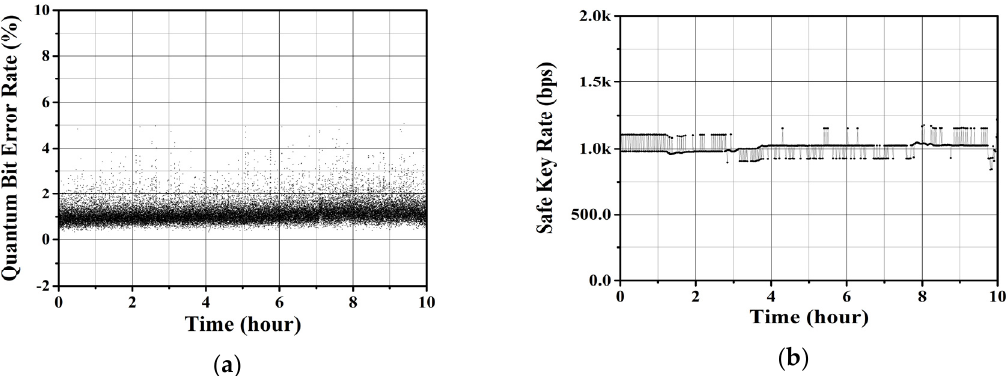
Figure 5. Temporal fluctuation of the key generation performance. ( a ) the quantum bit error rate as a function of time; ( b ) the safe key rate as a function of time, where every point is the average safe key rate in one minute.